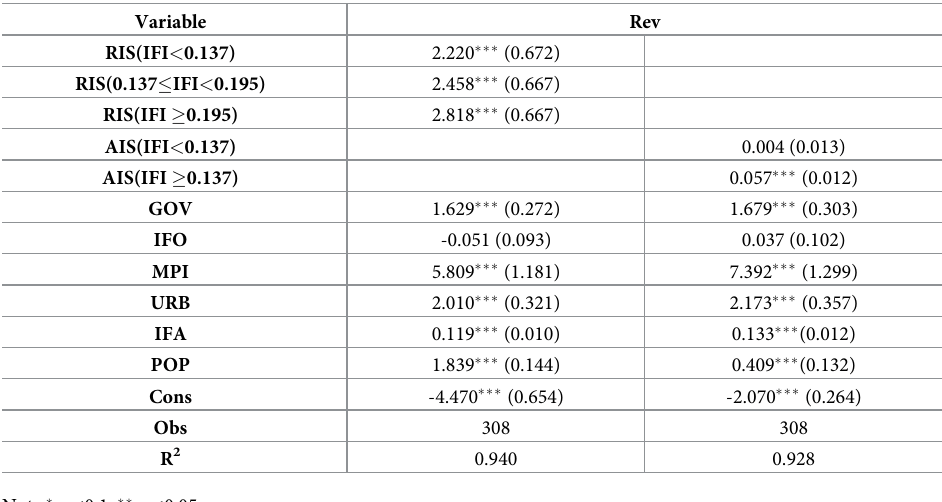
Table 15. Regression results for the panel